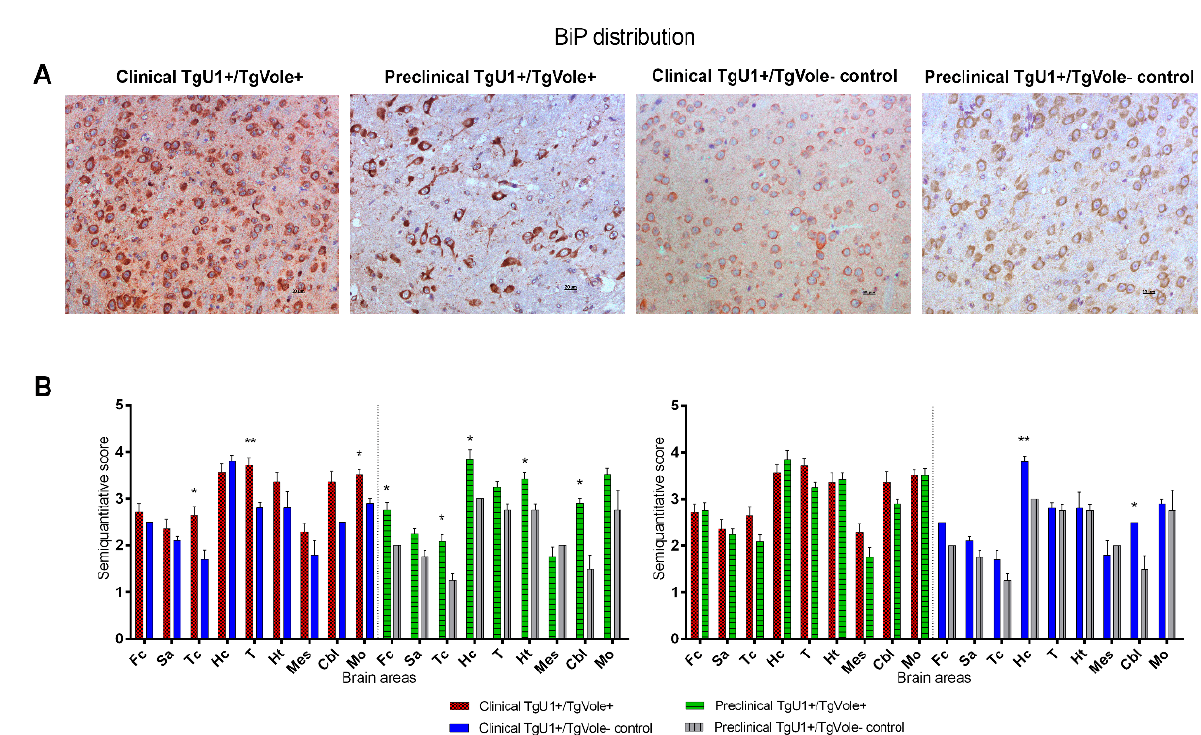
Figure 2. Binding immunoglobulin protein (BiP) expression levels are higher in clinical and preclinical TgU1 + /TgVole + mice than in healthy TgU1 + /TgVole - controls in certain brain areas. ( A ) All groups of mice presented uniform cytoplasmic labeling of BiP in numerous neurons and a diffuse staining in the neuropil. Immunostaining intensity, rather than the number of positive cells, was higher in both clinical and preclinical TgU1 + /TgVole + compared to their age-matched controls. ( B ) BiP distribution in the brains of clinical and preclinical TgU1 + /TgVole + mice and their age-matched controls. BiP immunostaining was analyzed using a semiquantitative scale from 0 (lack of immunostaining) to 5 (very intense immunostaining) in nine different brain areas: frontal cortex (Fc), septal area (Sa), cortex at the level of the thalamus (Tc), hippocampus (Hc), thalamus (T), hypothalamus (Ht), mesencephalon (Mes), cerebellum (Cbl) and medulla oblongata (Mo). The number of animals included in each group was: clinical TgU1 + /TgVole + n = 6 (4 female, 2 male), clinical TgU1 + /TgVole − controls n = 8 (6 female, 2 male), preclinical TgU1 + /TgVole + n = 5 (2 female, 3 male) and preclinical TgU1 + /TgVole − controls n = 5 (2 female, 3 male). Comparison of the BiP immunolabeling revealed significant differences between clinical TgU1 + /TgVole + mice and clinical TgU1 + /TgVole − controls and between preclinical TgU1 + /TgVole + mice and preclinical TgU1 + /TgVole − controls in different brain areas. No differences were observed between clinical and preclinical TgU1 + /TgVole + mice. (* p < 0.05, ** p < 0.01, Mann-Whitney U